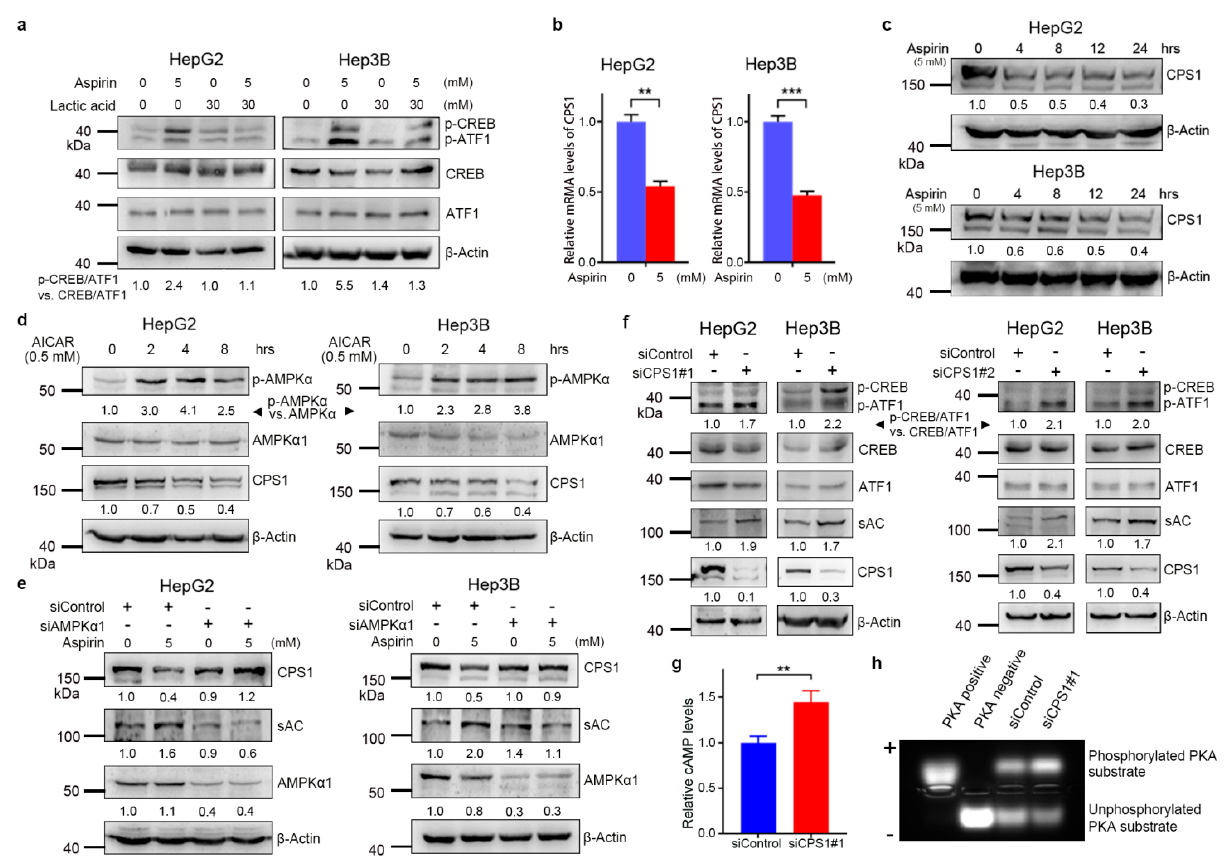
Figure 3. Aspirin inhibits carbamoyl phosphate synthase 1 (CPS1) expression through AMPK activation, and CPS1 knockdown leads to increased cAMP levels, PKA activity and CREB/ATF1 phosphorylation in hepatocellular carcinoma (HCC) cells. ( a ) HepG2 and Hep3B cells were incubated with or without aspirin. Thirty hours later, the cells were treated with lactic acid for another 2 h, followed by Western blot analysis of indicated proteins. The relative levels of p-CREB/ATF1 normalized to total CREB/ATF1 were shown. ( b ) HepG2 and Hep3B cells were treated with or without aspirin for 48 h, followed by real-time RT–PCR analysis of CPS1 transcription. The relative mRNA levels were plotted. Values represent means ± SD ( n = 3). **, p < 0.01, ***, p < 0.001. ( c ) HepG2 and Hep3B cells were treated with aspirin for indicated hours, followed by Western blot analysis of CPS1 expression. The relative levels of CPS1 were shown. ( d ) HepG2 and Hep3B cells were treated with AICAR for indicated hours, followed by Western blot analysis of indicated proteins. The relative levels of p-CREB/ATF1 normalized to total CREB/ATF1, and the relative levels of CPS1 normalized to β -actin were shown. ( e ) HepG2 and Hep3B cells were transfected with siControl or siAMPK α 1 and treated with or without aspirin for 48 h, followed by Western blot analysis of indicated proteins. The relative levels of CPS1, sAC and AMPK α 1 normalized to β -actin were shown. ( f ) HepG2 and Hep3B cells were transfected with siControl or two different siRNA duplexes against CPS1 (siCPS1#1, siCPS1#2) for 48 h, followed by Western blot analysis with indicated antibodies. The relative levels of p-CREB/ATF1 normalized to total CREB/ATF1, and the relative levels of CPS1, sAC normalized to β -actin were shown. ( g ) HepG2 cells were transfected with siControl or siCPS1#1 for 48 h, followed by cAMP assays. The relative cAMP levels were plotted. Values represent means ± SD ( n = 3). **, p < 0.01. ( h ) HepG2 cells were transfected with siControl or siCPS1#1 for 48 h, followed by PKA kinase assay. PKA-phosphorylated substrate migrated toward the anode (+), whereas the unphosphorylated substrate migrated toward the cathode